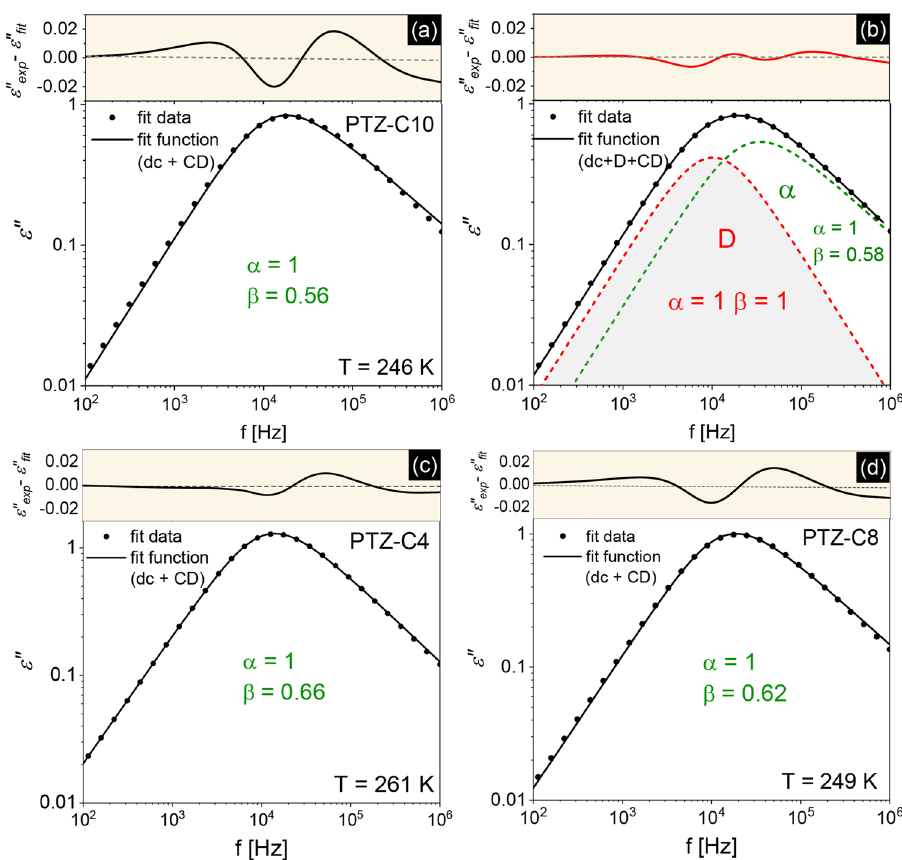
Figure 3. ( a , b ) The analysis of dielectric loss spectra for PTZ-C10 at T = 246 K for different fit strategies. Experimental data points are depicted as circles. The solid line is a resultant fit function, while the dashed line shows the fitting components. The values of shape parameters of the HN function (Eq. 1) are indicated. The upper panels show the differences between the experimental data points and fitted values. For comparison, the effect of single-function analysis for PTZ-C4 ( c ) and PTZ-C8 ( d ) is presented as